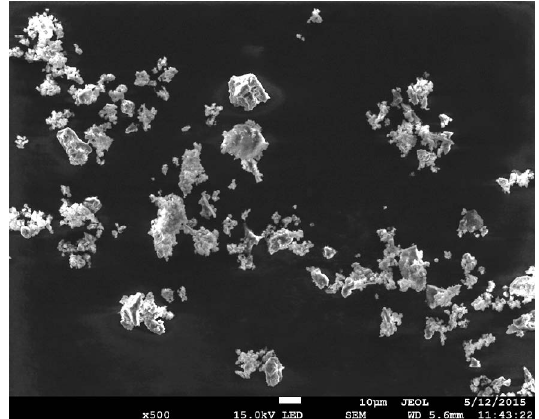
Fig. 5 SEM photo of particles at the cyclone